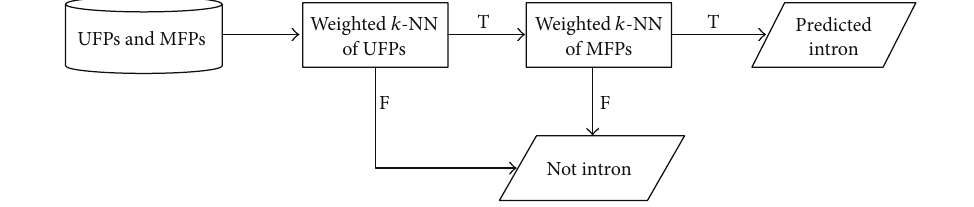
Figure 5: Two-layered nearest neighbor classifier.